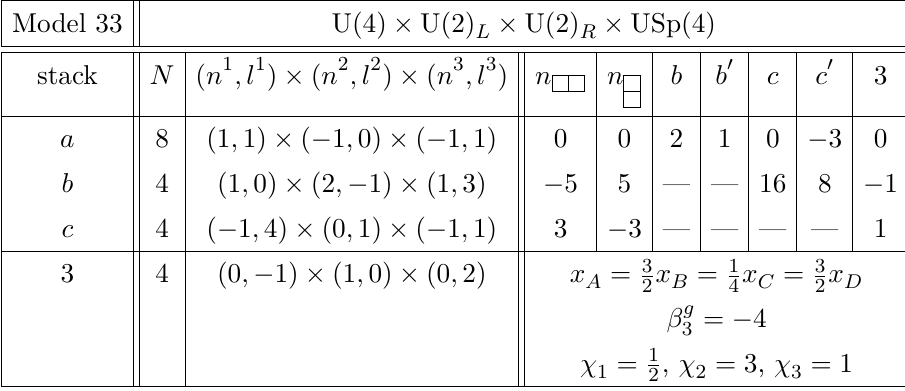
Table 40 . D6-brane configurations and intersection numbers of Model 33, and its MSSM